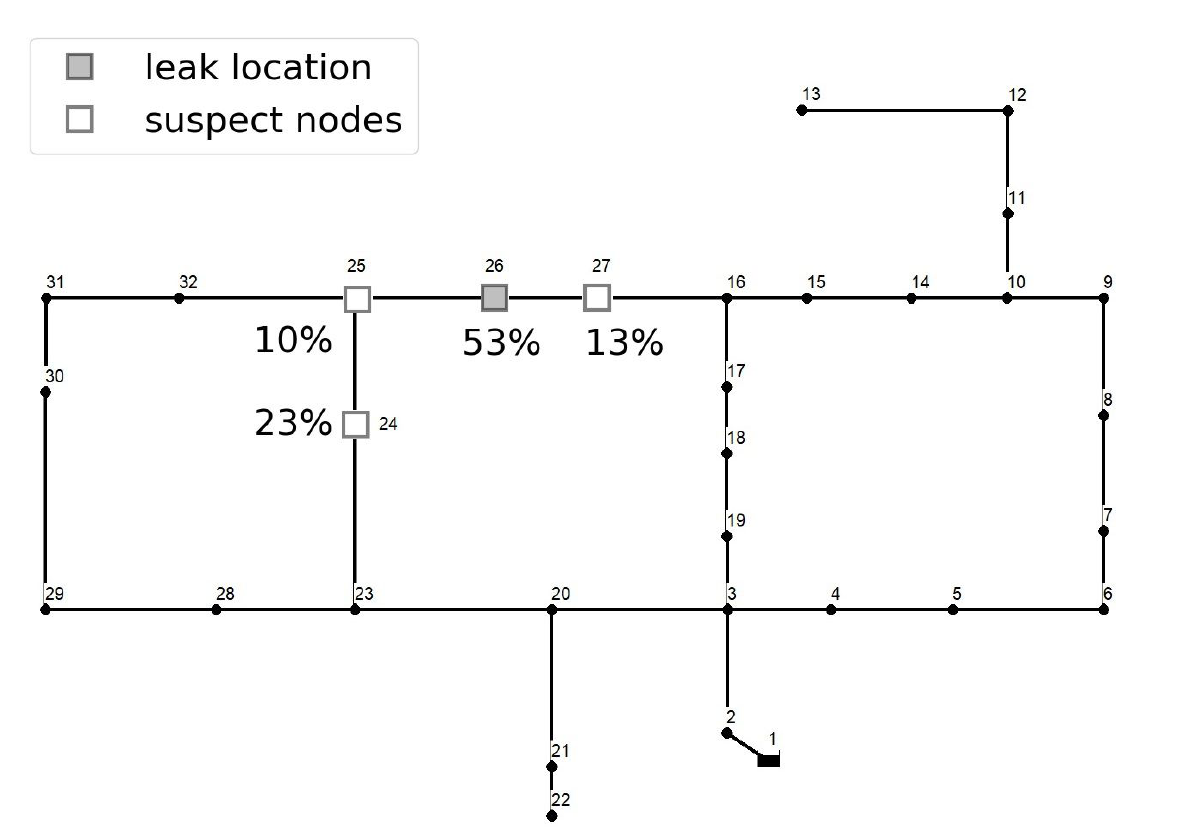
Figure 5. Prediction of leak location for 30 day measurements with percentage of predicted leak